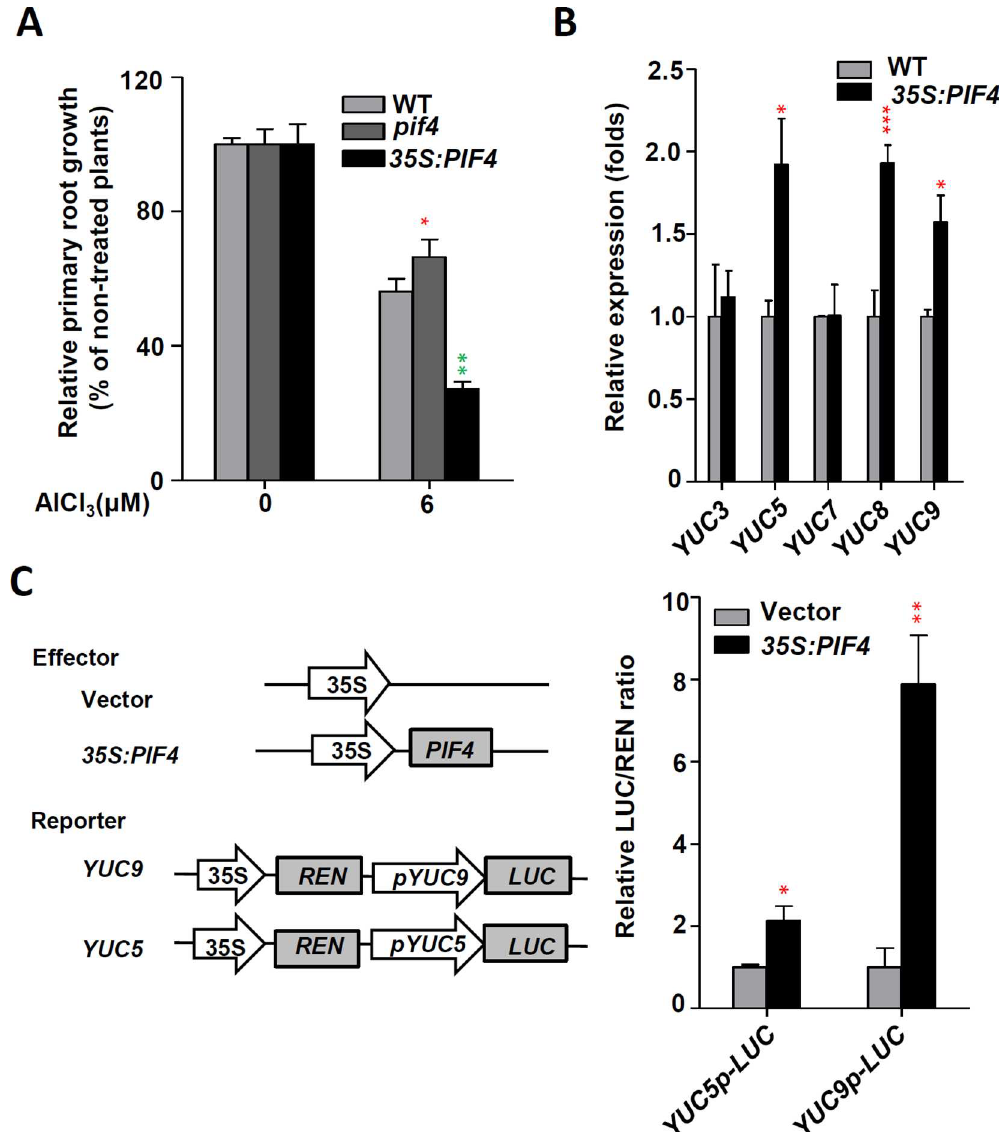
Fig 8. PIF4 regulates expression of YUC s in Al stressconditions. (A) Root growth of WT, pif4 and 35S : PIF4 plants after a seven-dayexposure to 0 or 6 μ M AlCl 3 . Three independent experiments were done, each with three replicates. Plants were grown at 22˚C in long days growth conditions. Error bars represent Student’s t test confidence intervals (n (cid:21) 30). Statistical difference from expected indicatedby asterisks (Fisher’s exact test, * P < 0.05, ** P < 0.01). (B) Relativetranscript abundance of YUC3 , YUC5 , YUC7 , YUC8 and YUC9 genes in 7-d-old WT and 35S : PIF4 seedlingsroots. Data represent the mean of three biologicalreplicates. Statistical difference is indicatedby asterisks (Fisher’s exact test, * P < 0.05, *** P < 0.005). (C) Left panel: Schematic diagrams of effector and reporter constructs used in the transient dual-luciferase assays. CaMV 35S promoter driving PIF4 ( 35S : PIF4 ) was used as effector, and empty vector as a negative control. Promoter fragments of YUC5 and YUC9 were used to make the YUC5p-LUC and YUC9p-LUC reporters. Right panel: Transient dual-luciferase assay shows that PIF4 transactivates the promoters of YUC5 and YUC9 in Arabidopsis protoplasts. Data represent the mean of three biologicalreplicates. Statistical difference are indicatedby asterisks (Fisher’s exact test, * P < 0.05, ** P <